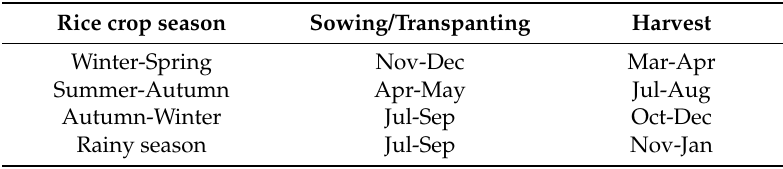
Table 1. Main rice seasons in An Giang, Mekong River Delta, Vietnam.